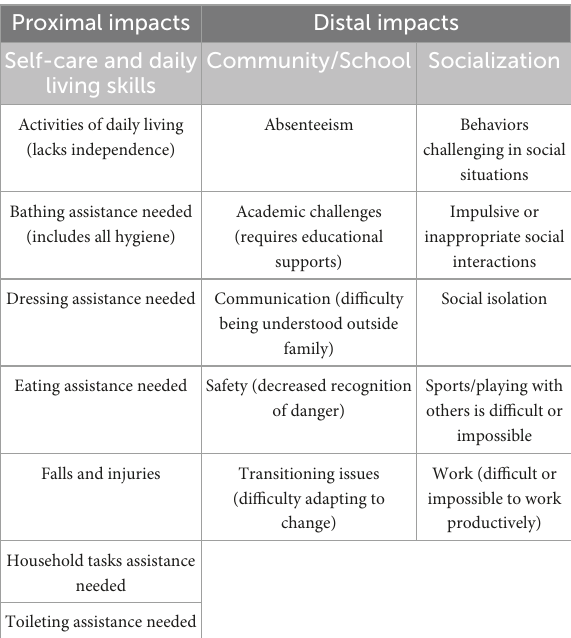
TABLE 2 Individual impacts of SLC6A1-related neurodevelopmental disorder.